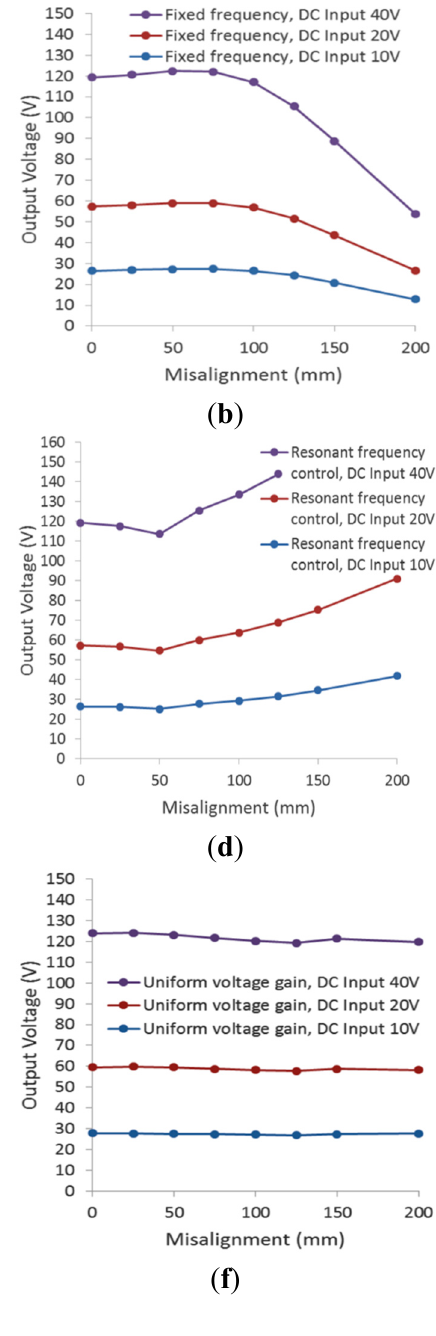
Figure 7. Experimental comparison in three control modes at a fixed air gap of 100 mm and different misaligned coil conditions. ( a ) Efficiency at a fixed frequency; ( b ) Voltage at a fixed frequency; ( c ) Efficiency at resonant frequencies (phase angle θ = 0); ( d ) Voltage at resonant frequencies (phase angle θ = 0); ( e ) Efficiency at uniform gain frequencies; ( f ) Voltage at uniform gain